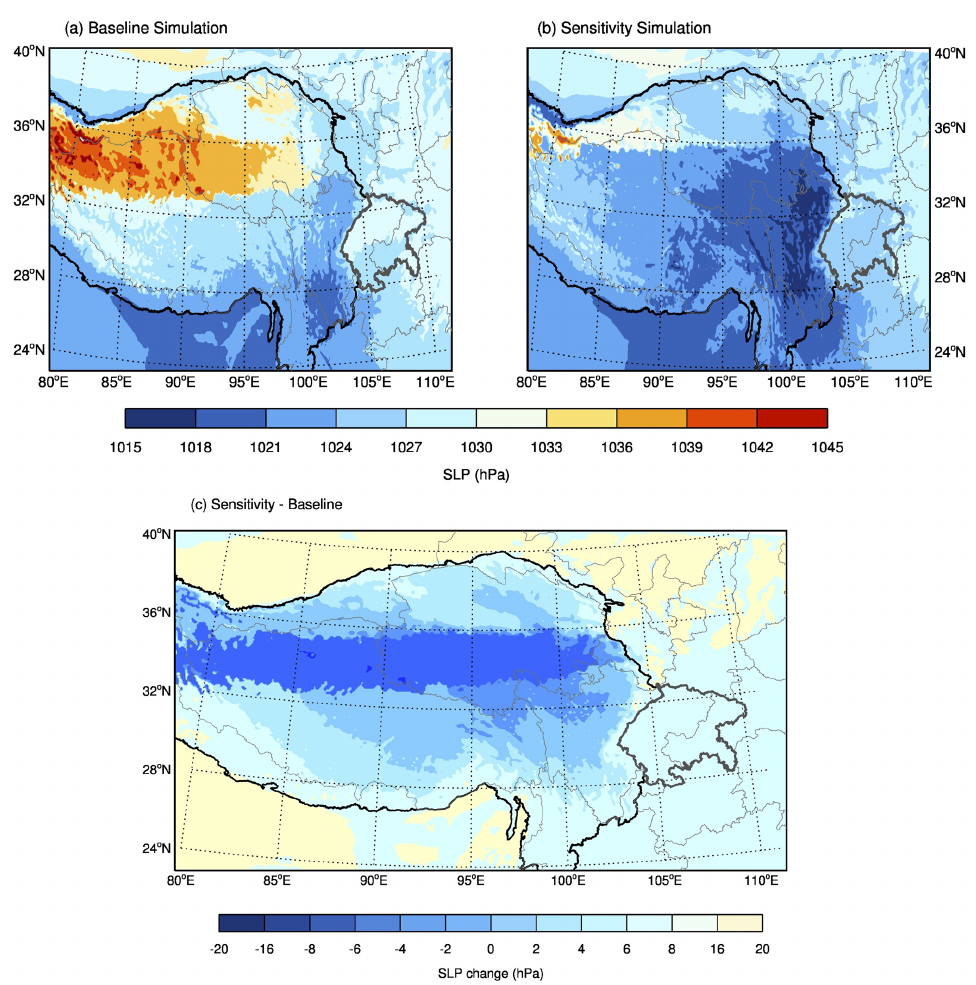
Figure 8. Comparison of spatial distributions of sea level pressure (SLP) between the (a) baseline simulation and (b) sensitivity simulation over the Tibetan Plateau and Sichuan Basin. (c) Changes in SLPs (sensitivity simulation minus baseline simulation) over the plateau and basin while the plateau warms by 2 ◦